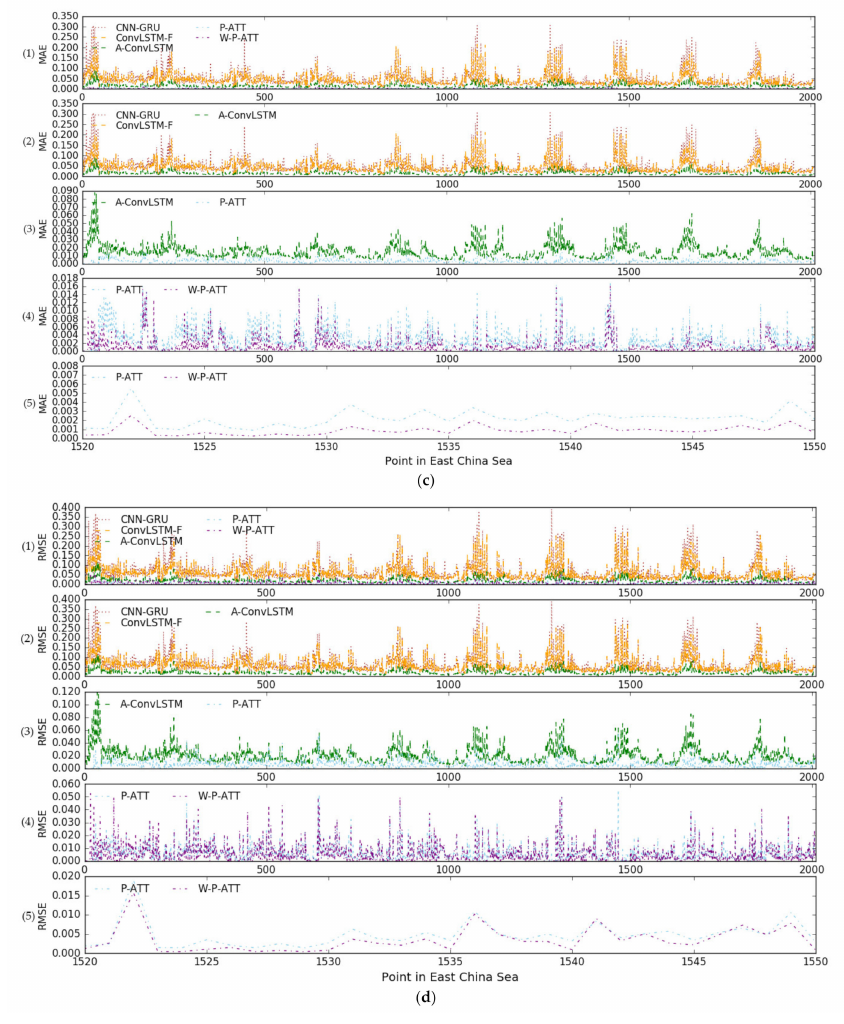
Figure 11. ( a ) The comparison of MAE between different models—u_current, ( b ) The comparison of RMSE between different models—u_current, ( c ) The comparison of MAE between different models— v_current, ( d ) The comparison of RMSE between different models—v_current. The subfigure (1) is for all five models, the subfigure (2) is the comparison between CNN-GRU, ConvLSTM-F, and A-ConvLSTM, the subfigure (3) is the comparison between A-ConvLSTM and P-ATT, the subfigure (4) is the comparison between P-ATT and W-P-ATT, and the subfigure (5) is the comparison between P-ATT and W-P-ATT through a short point range from point 1520 to point